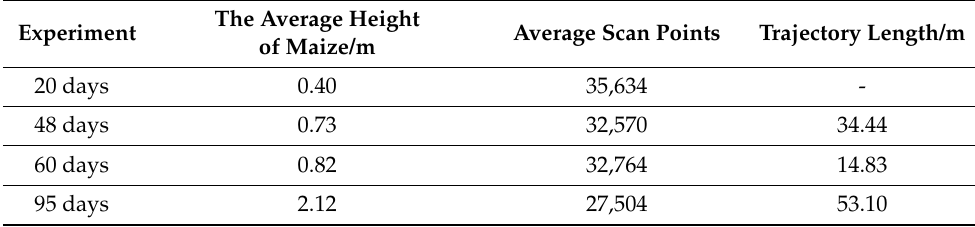
Table 2. The details of each point cloud data.